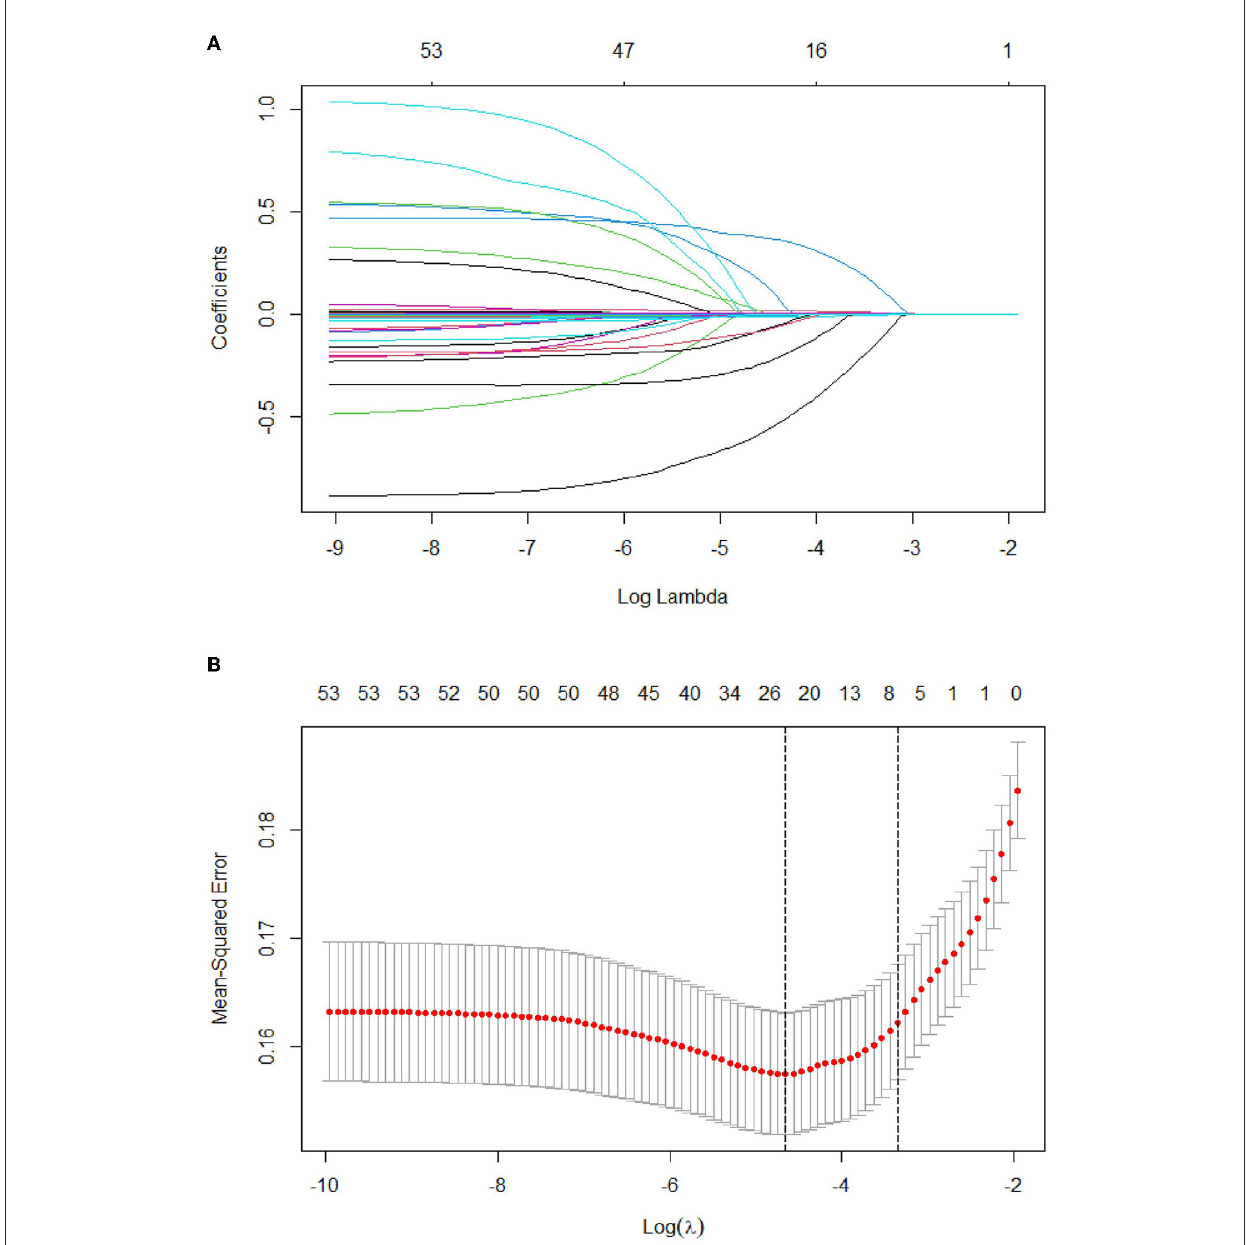
FIGURE2 Tuning parameter selection using the LASSO regression in the training cohort. (A) LASSO coefficient profiles of the clinical features. (B) The optimal penalization coefficient lambda was generated in the LASSO via 10-fold cross-validation. The lambda value of the 1-fold mean square error for the training cohort was